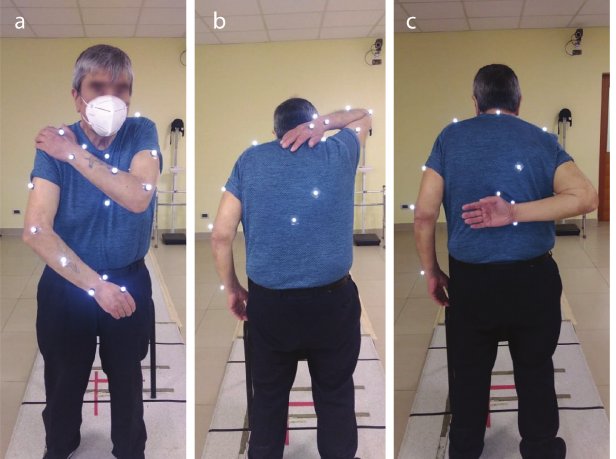
Figure 4. Apley Scratching Test sequence. ( a ) Action 1, ( b ) Action 2, and ( c ) Action